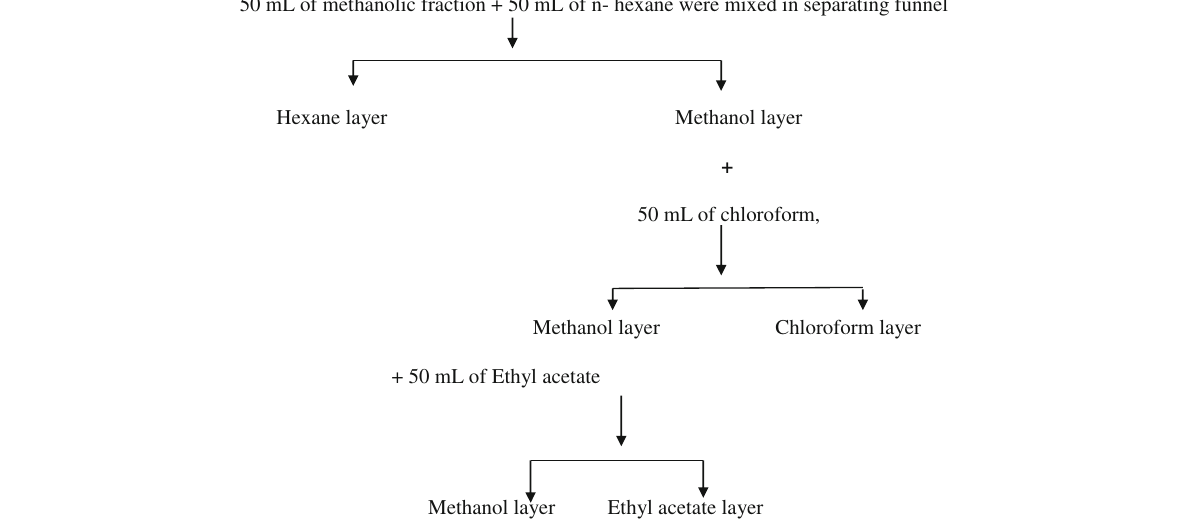
Fig. 2 Successive extraction procedure of saponins from internodes and leaves of cotton plants var. Vikram grown in filter control (FC) and UV-B excluded conditions.